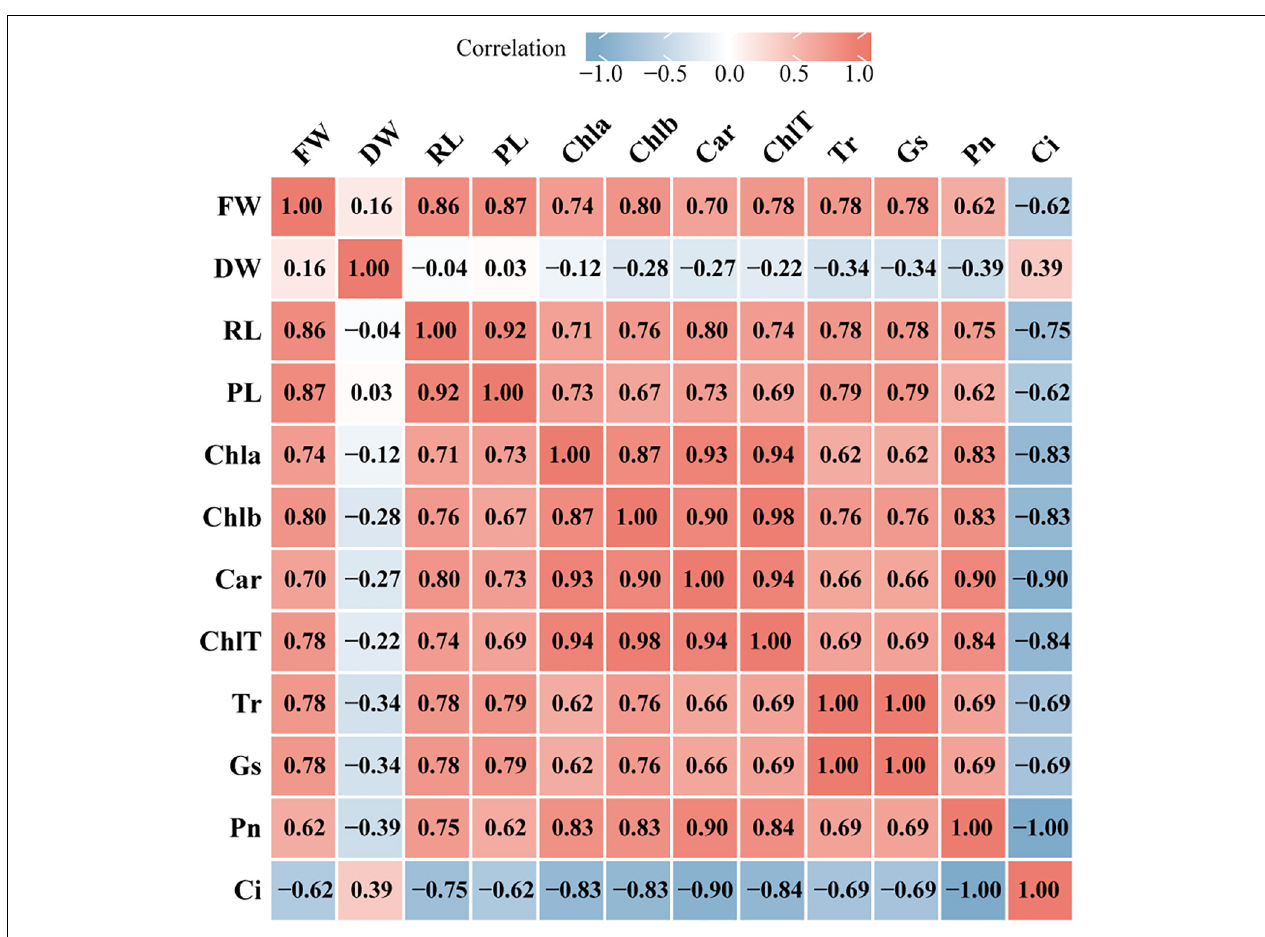
FIGURE 8 | Heatmap of correlation between growth indicators and photosynthetic physiology indicators. The image show Spearman correlation and the values in the grid represent correlation coefficients ( r values). The red color indicates a positive (0 < r < 1.0) correlation and the blue color indicates a negative (–1.0 < r < 0) correlation. Strength of correlation: absolute values of r > 0.7 indicate strong correlation, 0.4 < absolute values of r ≤ 0.7 indicate moderate correlation, absolute values of r ≤ 0.4 indicate weak correlation. FW, fresh weight; DW, dry weight; RL, root length; PL, plant length; Chla, chlorophyll a ; Chlb, chlorophyll b ; Car, carotenoid; ChlT, total chlorophyll; Tr, transpiration rate; GS, stomatal conductance; Pn, net photosynthesis rate; Ci, intercellular CO 2